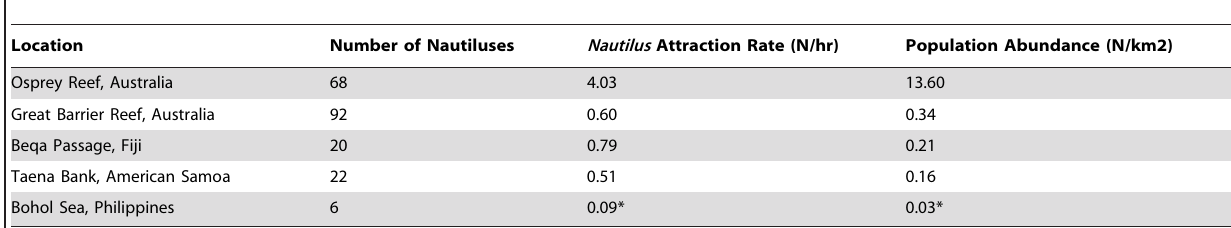
Table 1. Population abundance values of the each location sampled including prior data from Osprey Reef, Australia 10 representing all currently sampled Nautilus